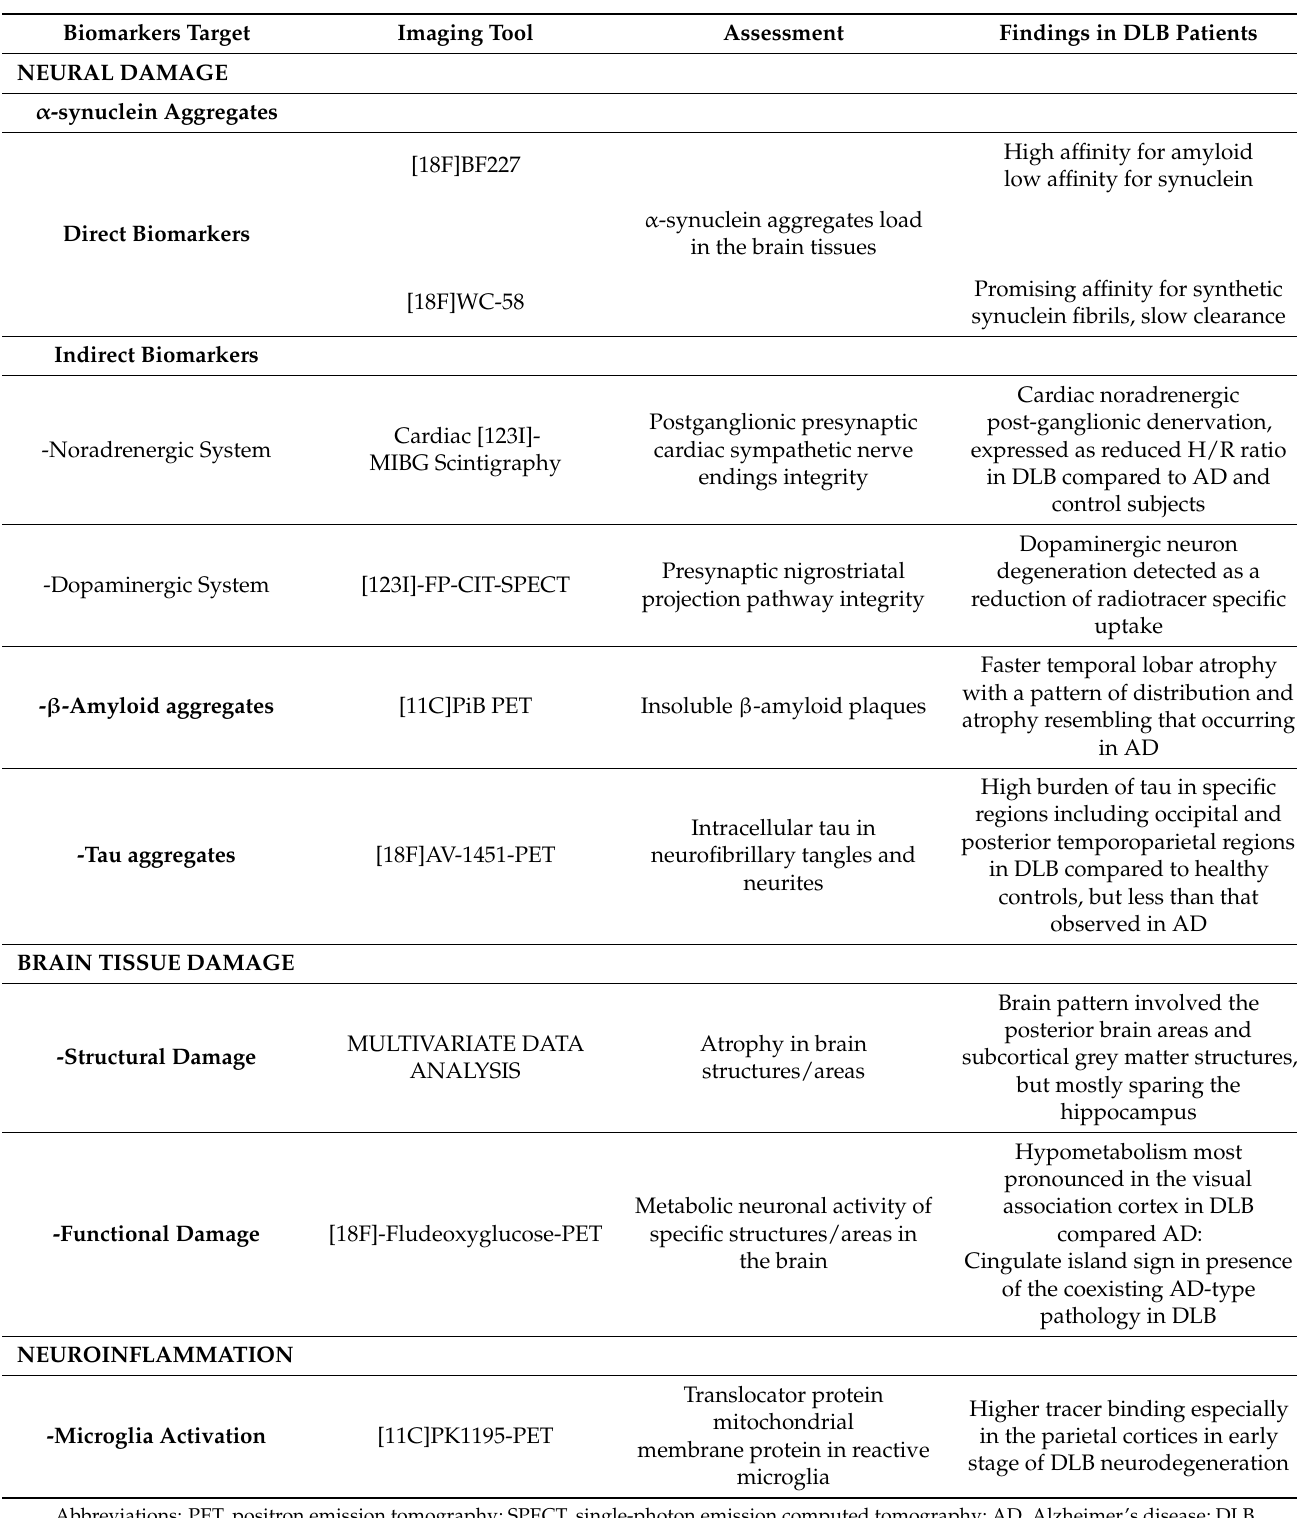
Table 2. Neuroimaging Biomarkers in Lewy Body Dementia